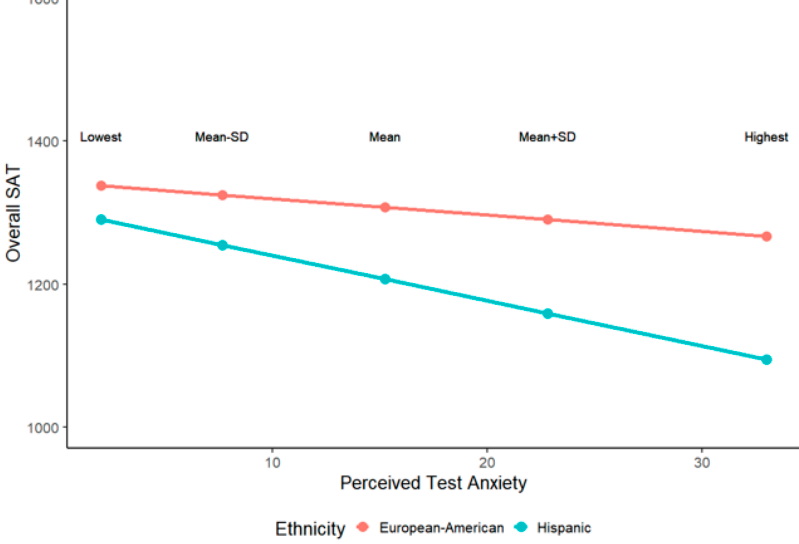
Figure 3. Reproduced visualization of overall SAT scores as a function of ethnicity and test anxiety, and their interaction when controlling for cognitive abilities, performance-avoidance, metacognitive awareness, and SES.